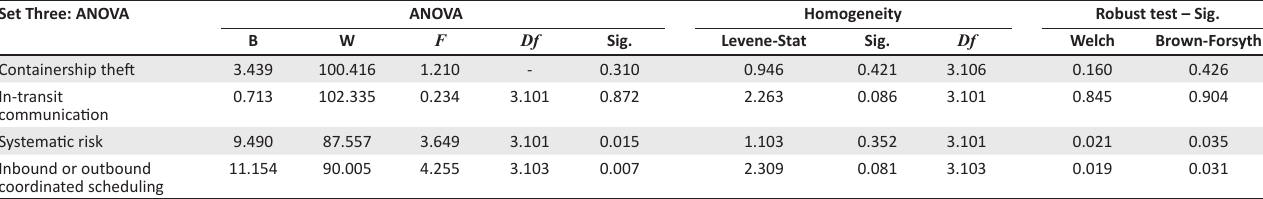
TABLE 4: Analysis of variance on supply chain technological advancements. Set Three: ANOVA ANOVA